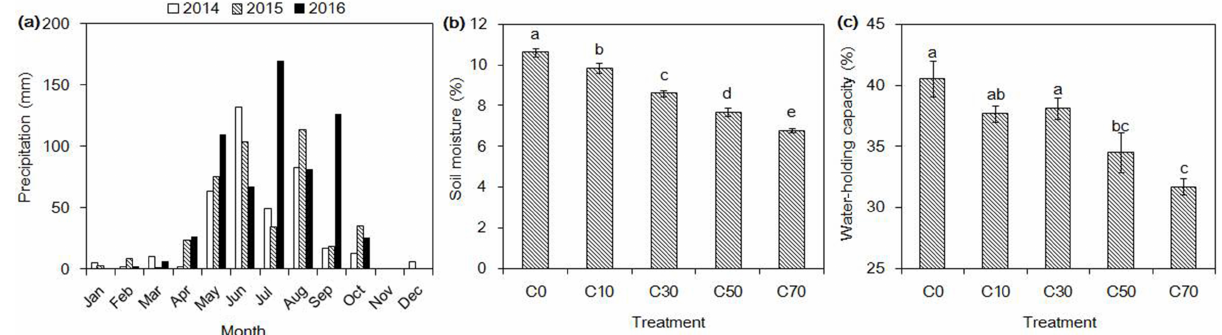
Figure 2. Monthly precipitation from 2014 to 2016 (a) and response of moisture (b) and water-holding capacity (c) in soil samples taken in October 2015 to different degrees of soil coarseness: 0% sand addition (C0), 10 (C10), 30 (C30), 50 (C50), and 70% (C70). Data represent mean ± standard error ( n = 6). Letters indicate significant differences among treatments.